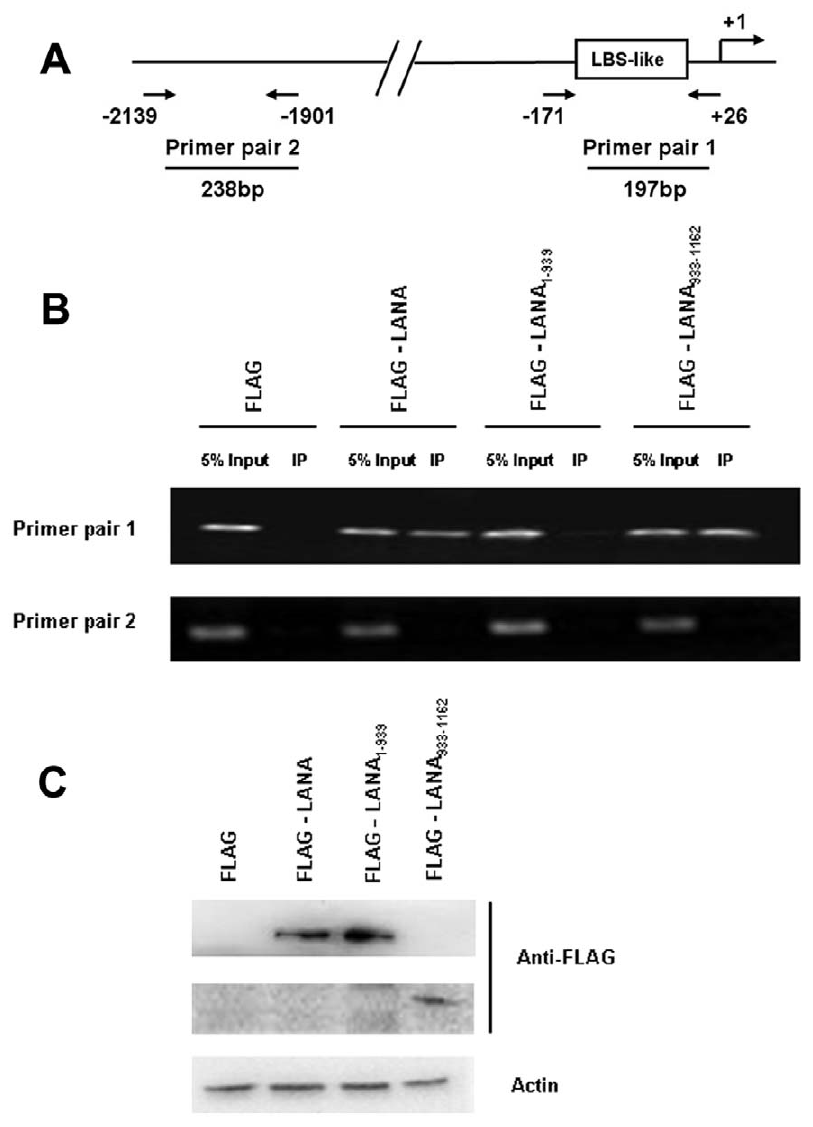
Figure 5. LANA interacts with the IL-22R1 promoter in vivo. ( A ) Schematic diagram showing the locations of the two pairs of primers used in the ChIP assay. ( B ) Formaldehyde cross-linked chromatin was prepared from 293T cells that were transfected with pFLAG, pFLAG-LANA, pFLAG- LANA 1–939 or pFLAG-LANA 933–1162 , and immunoprecipitated with anti-FLAG antibody. PCR was performed with primer pair 1 to amplify a 197 bp DNA fragment containing LBS or with primer pair 2 to amplify a 283 bp DNA fragment, approximately 2 kb upstream of LBS-like sequence in IL-22R1 promoter. A sample representative of 5% the total input chromatin was included in the PCR analysis. ( C ) The expression levels of LANA and its truncated mutants were detected in cell lysates by western blotting using anti-FLAG antibody and anti-actin served as a loading